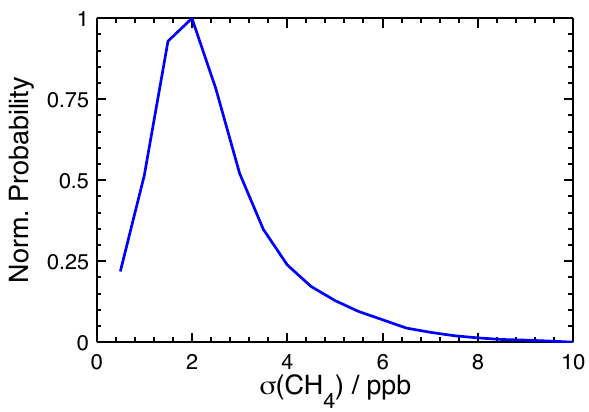
Fig. 7. PDF of the standard deviation of CH 4 measurements ob- tained airborne (10 s averages). The precision during our airborne measurements is better than 2 ppb for more than 50 % of the time, and better than 4.5 ppb for more than 90 % of the time.